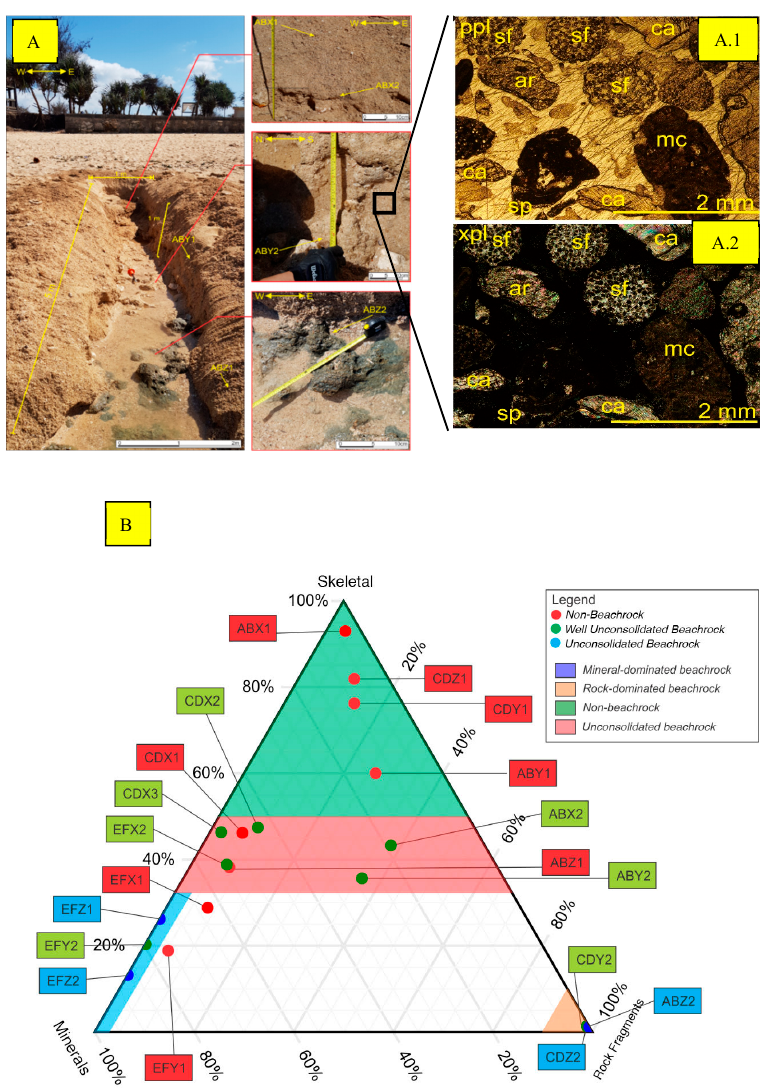
Figure 2. Stratigraphic of the Trench AB: (A) Petrographic on cross polarized nicol (XPL, A1) and plane polarized nicol (PPL, A2) with sf (skeletal fragment), mc (micrite), sp (sparite), ca (calcite) and ar (aragonite); (B) Degree of cementation based on composition of beachrock.